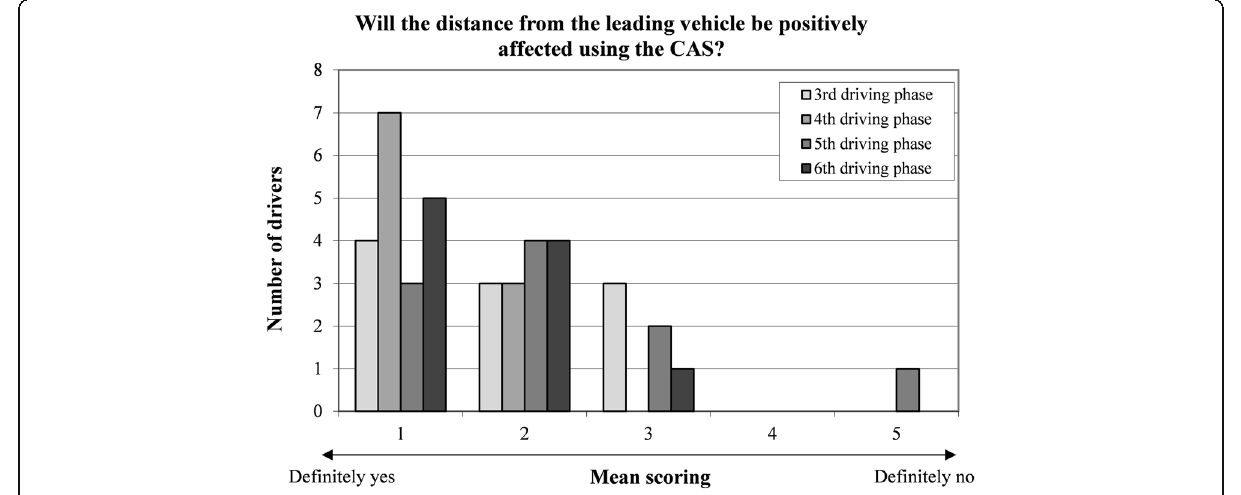
Fig. 1 Comparative results for the effect of CAS on the distance from the preceding vehicle for the driving phases 3 –